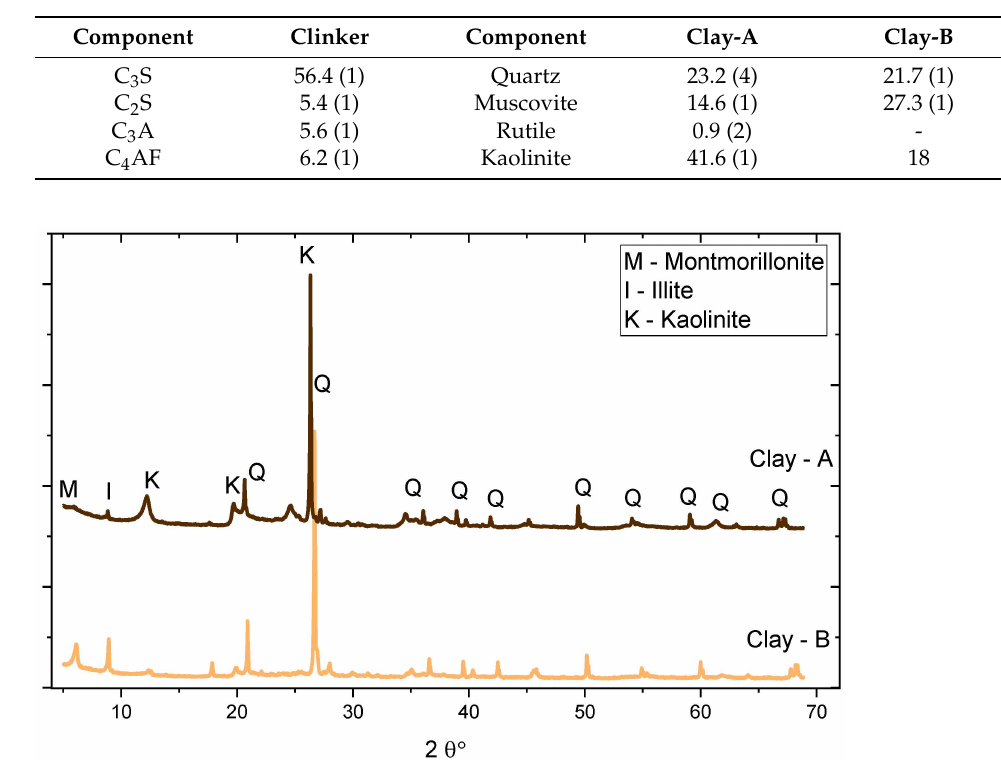
Figure 1. XRD pattern of raw clays.